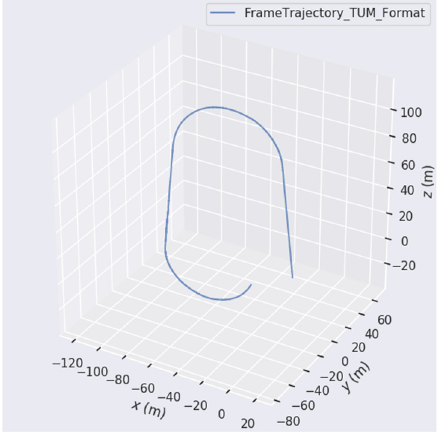
Figure 10. VINS-fusion positioning trajectory map.